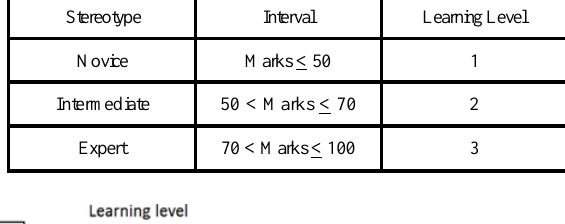
TABLE 3. LEARNING LEVEL AND STUDENTS’ STEREOTYPE